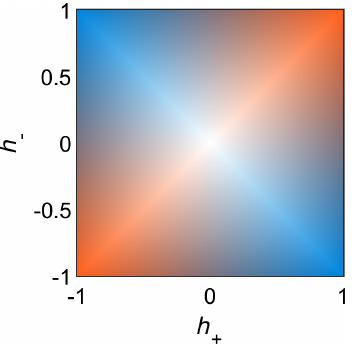
FIG. 4. Surface plot of the evolution of the reactive vs dissipative nature of the chiral optical environment in the helicity plane ð h þ ; h − Þ of the two counterpropagating beams. In agree- ment with Eqs. (13) and (14), c ¼ j h þ − h − j = 2 × ð c R − c A Þþ j h þ h j = 2 × ð c − c Þ þ c c , c c c þ − D A A , where R , D , and A are, respectively, the displayed, blue (for reactive), red (for dissipa- tive), and white (for achiral) colors.